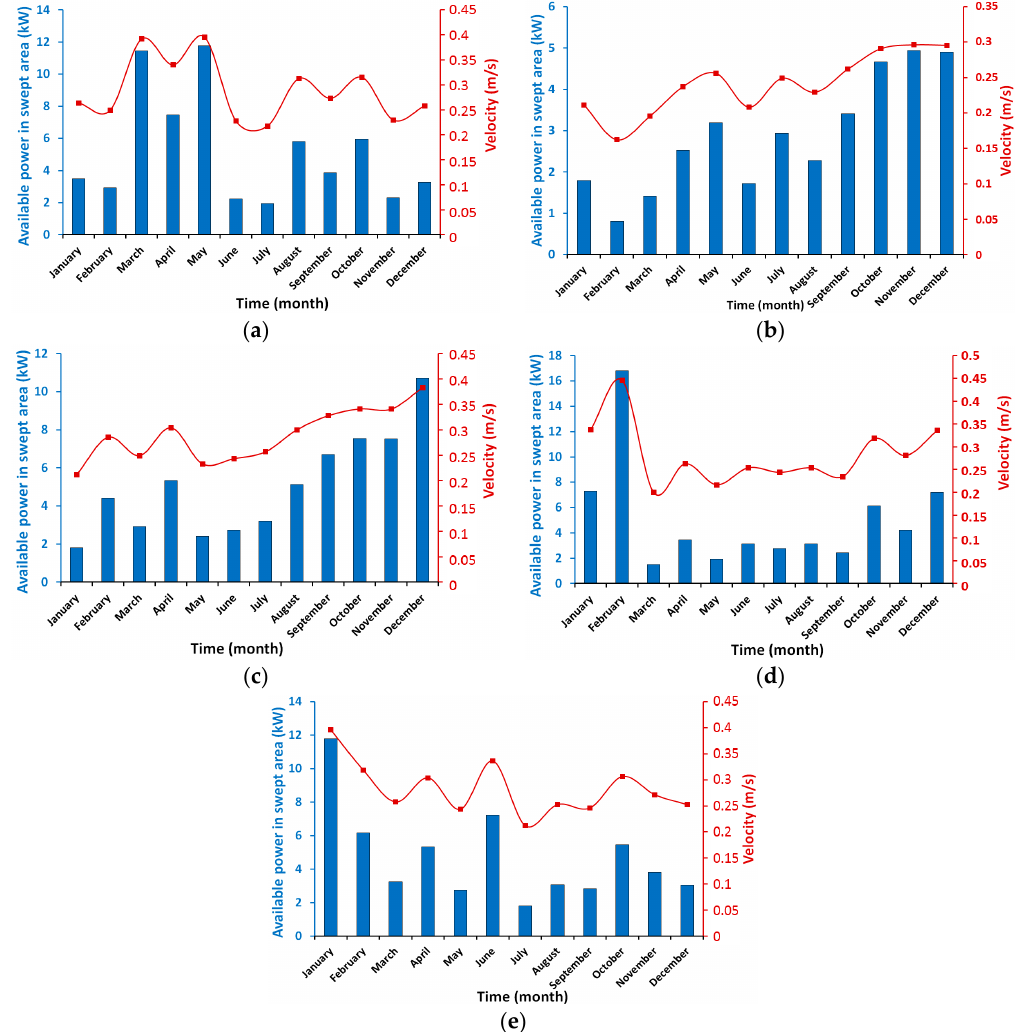
Figure 7. Tidal energy resource in the south coast of Atlantic. ( a ) 2010; ( b ) 2011; ( c ) 2012; ( d ) 2013; ( e ) 2014.